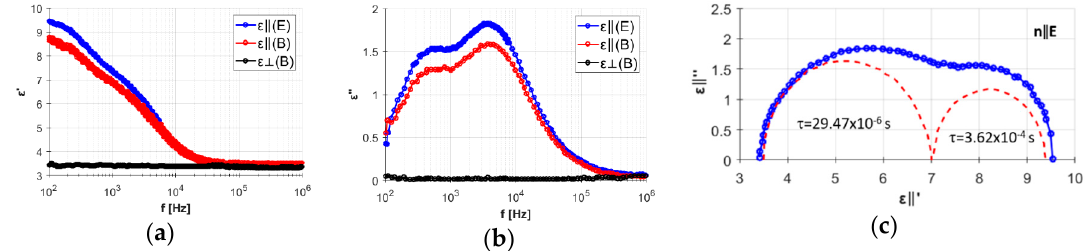
Figure 3. Frequency dependence of ( a ) real and ( b ) imaginary parts of the complex permittivity plotted in the measuring frequency range 100 Hz to 1MHz. ( c ) Cole–Cole plot showing relaxation process with two time constants.